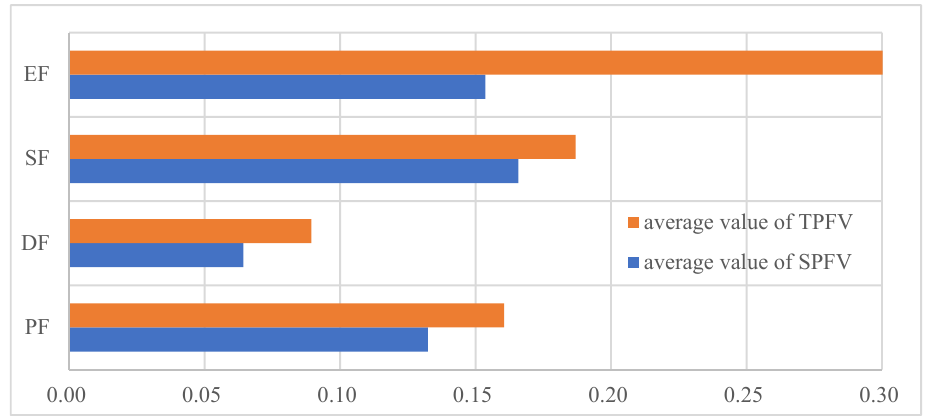
Figure 11. Average value of status and trend index of EFV, SFV, DFV, and PFV.